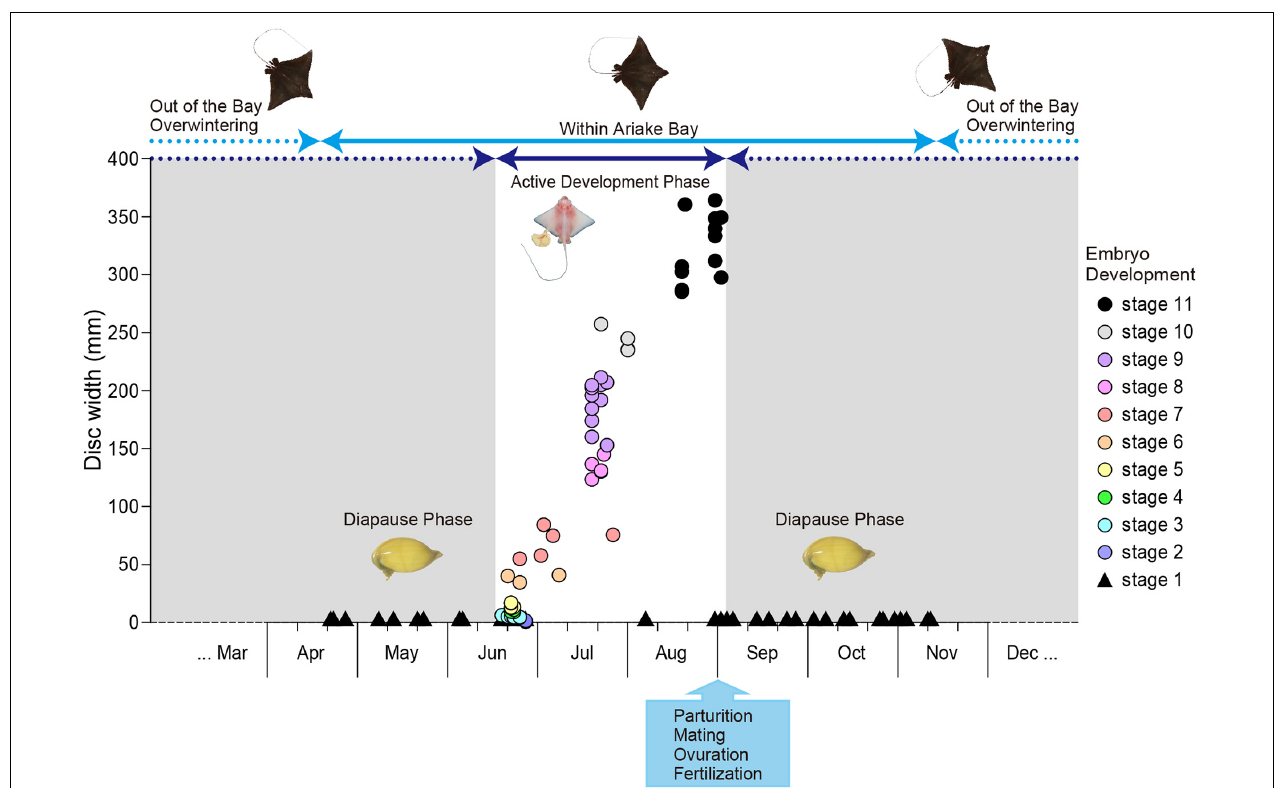
FIGURE 8 | Aetobatus narutobiei embryonic diapause and growth. Embryonic disc width (circles) by month with circle color representing embryonic development stages 2–11 and triangles shown for uterine eggs without macroscopic embryos (stage